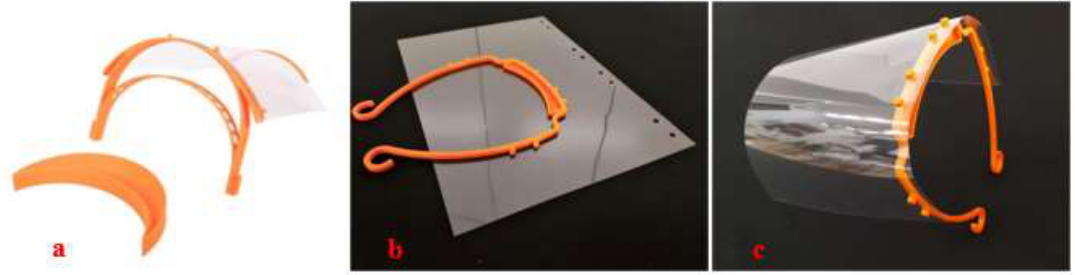
Figure 5. The 3D-printed ( a ) Prusa face shield [55] and ( b , c ) 3DVerkstan face shield [54].